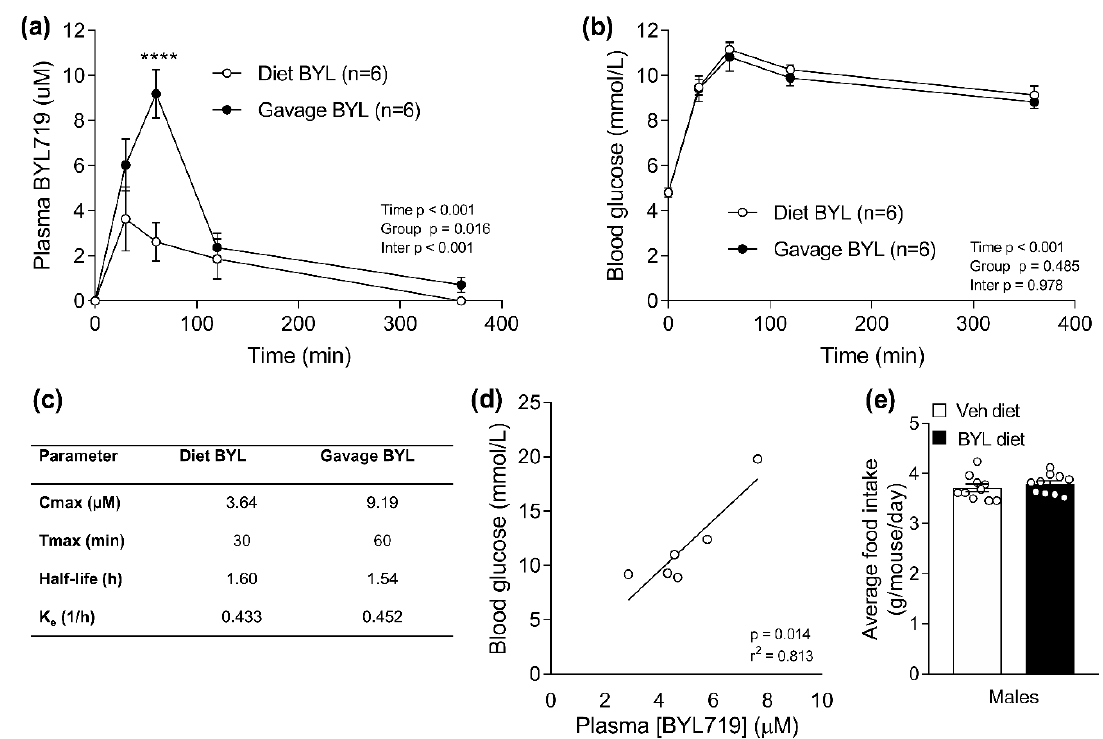
Figure 2. Pharmacokinetics ( a , b ) and changes in blood glucose ( c ) associated with delivering a single dose of BYL719 in the diet or via gavage in male mice. Plasma BYL719 ( d ) and food intake ( e ) of mice fed a control (Veh; vehicle) or BYL719 (BYL) containing diet for one week. Data are presented as mean ± SE, statistical analysis for ( a , b ) was by two-way repeated measures ANOVA with Sidak post-hoc, ( d ) by linear regression, and ( e ) by t -test. **** p < 0.001 vs. Veh at same time point. N = 6 per group for ( a – d ).